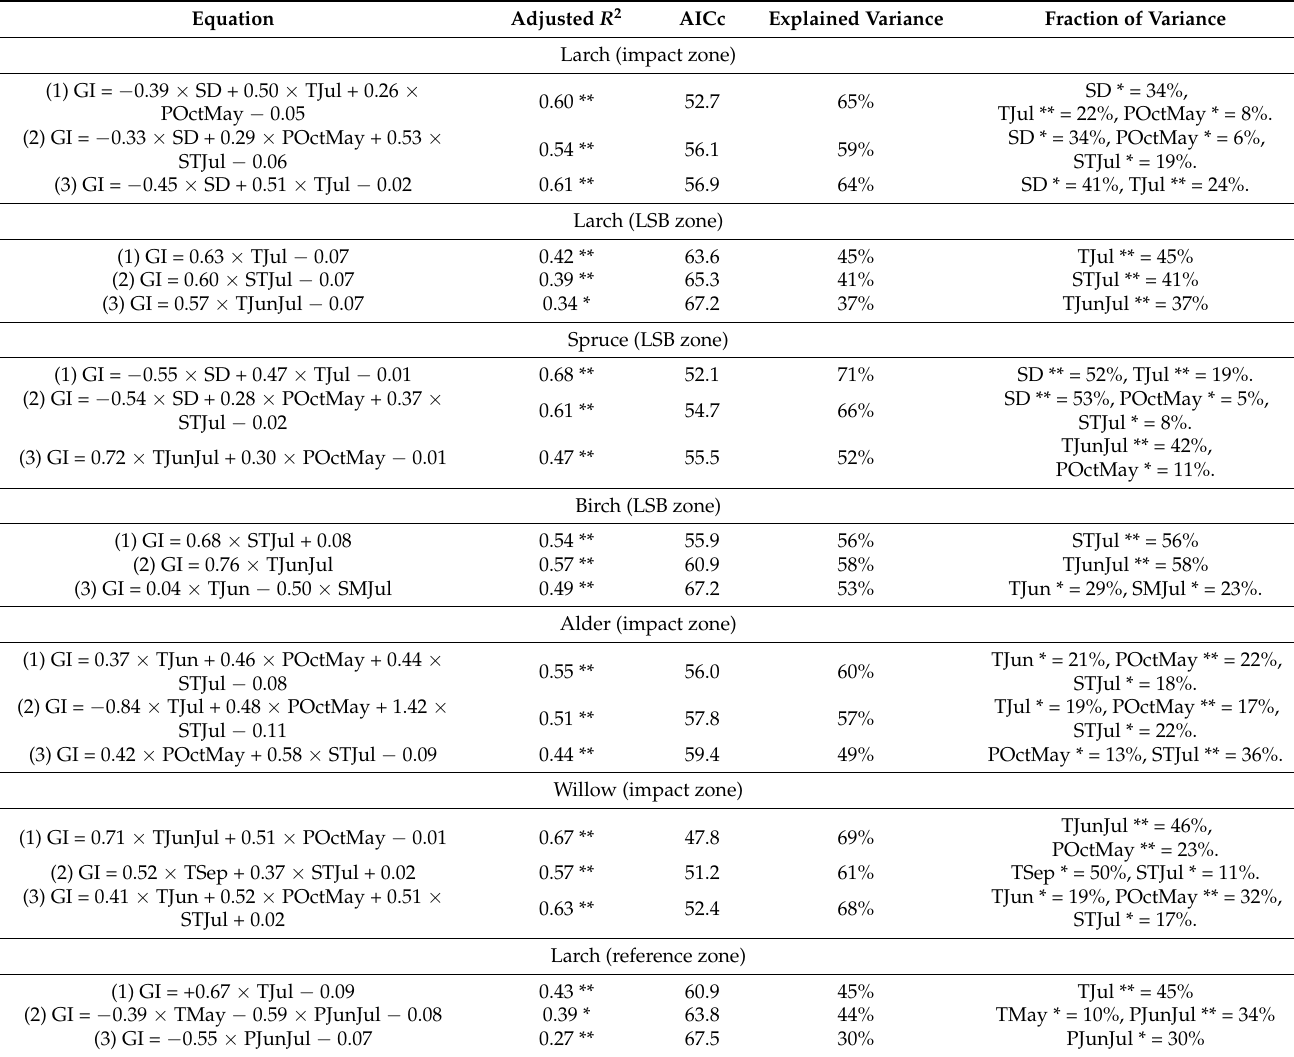
Table 2. Dependence of tree and bush species on the eco-climate variables. Abbreviations: LSB— mixed larch-spruce-birch zone; SD—sulfur dioxide emission; TMay, TJul, TJunJul, and TSep—air temperature in May, July, June–July, and September, respectively; STJul—July soil temperature; SMJul—July soil moisture; POctMay—October–May precipitation. Study period is 1993–2021. *— significant at p < 0.001; **—significant at p <